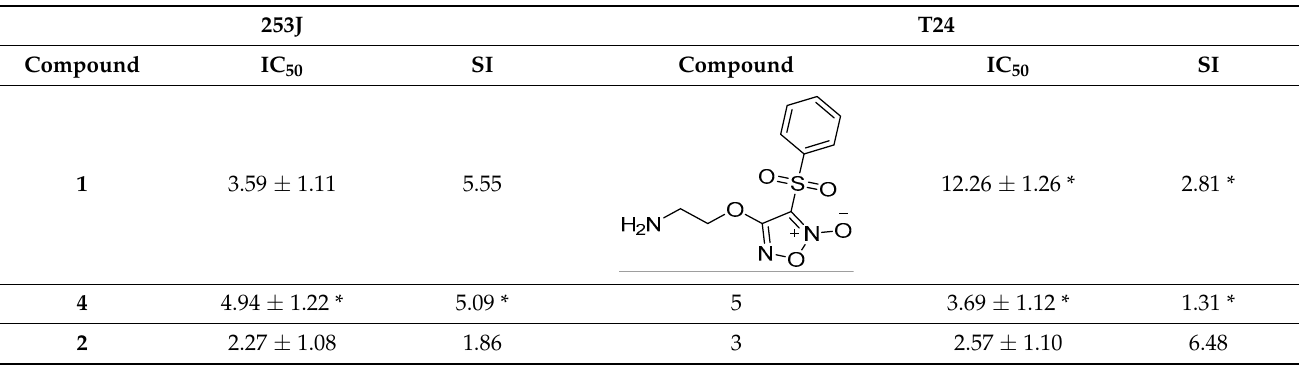
Table 3. Antiproliferative activity (IC 50 values in µ M ± standard deviation) and selectivity index (SI) of arylsulfonylfuroxan derivatives in 253J and T24 cancer cells.